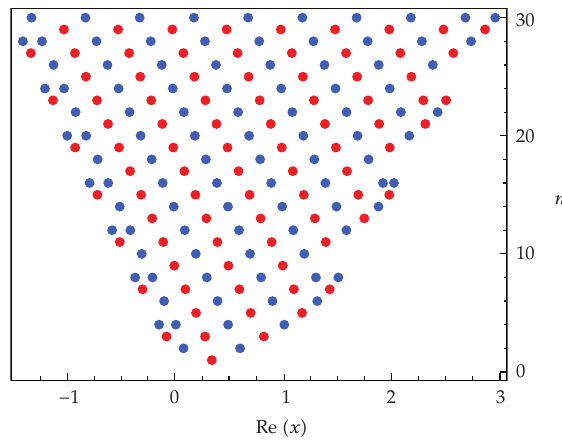
(cid:2) 3 (cid:3) (cid:2) x (cid:3) , q (cid:6) 1 / 2 , 1 ≤ n ≤ 30. n,q